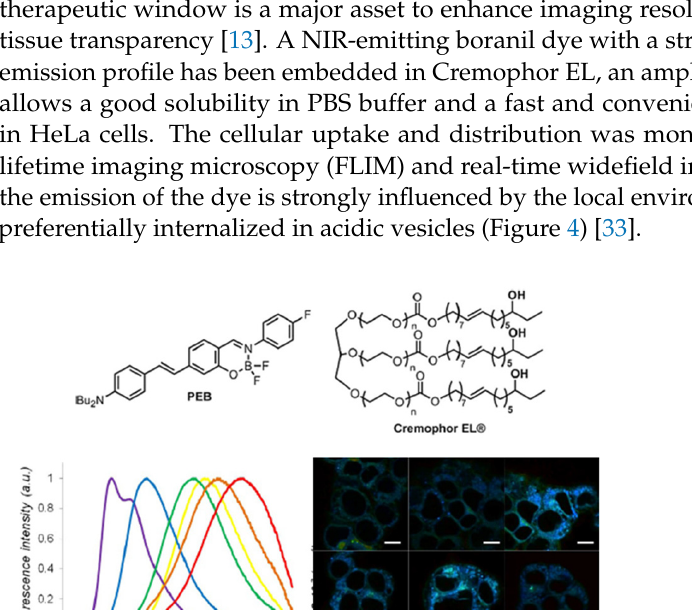
Figure 4. Cellular imaging using fluorescent boranils probes [33]. Emission spectra on the bottom left curves: (purple) cyclohexane, (blue) toluene, (green) THF, (yellow) DCM, (orange) acetone, (red) DMSO. Adapted from Reference [33]. Copyright 2017 John Wiley and Sons.